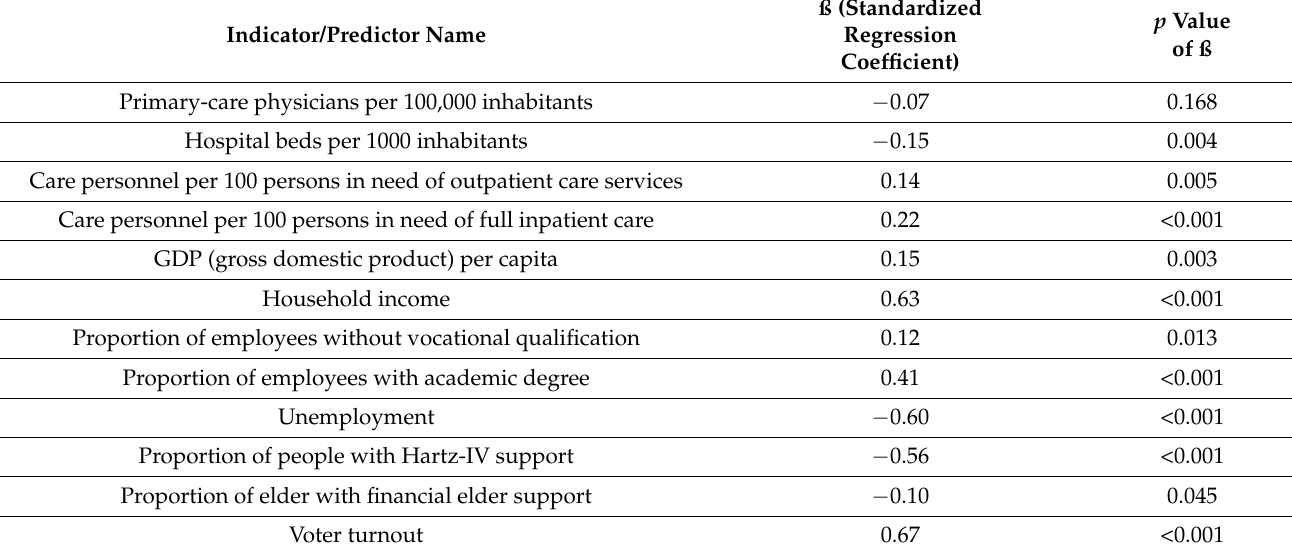
Table 2. Results of bivariate regression analyses of men’s remaining life expectancy at age 60 at district level (dependent variable) with 12 potential predictors: ß (standardized regression coefficient) and p value of ß; N = 401 German